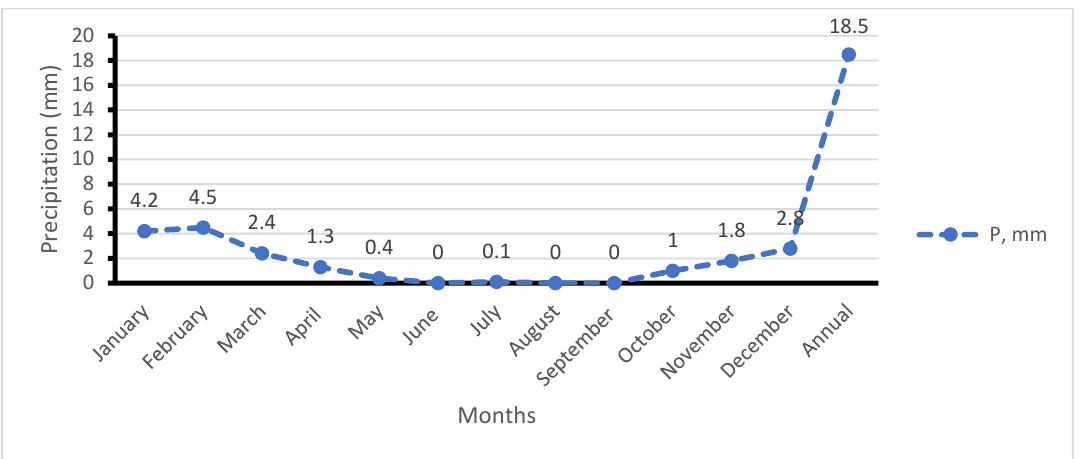
Figure 3. Precipitation (mm).